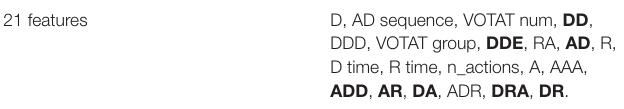
TABLE 6 | Features selected through the five-fold validated backward